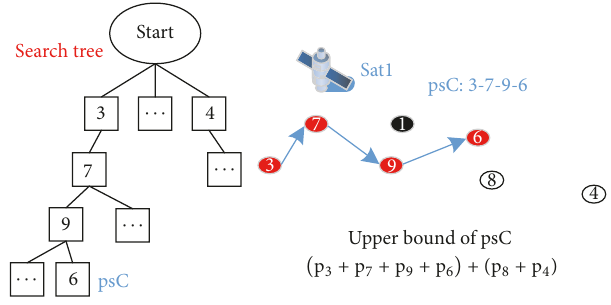
Figure 6: Schematic diagram of the upper bound.